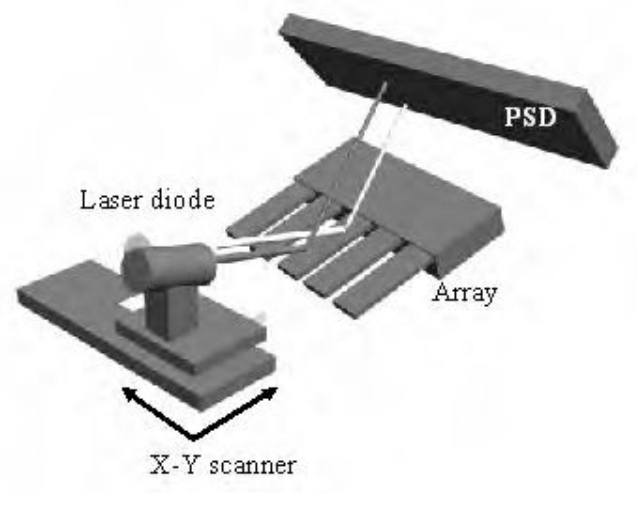
Figure 2 . Sketch of the profilometry system. The laser is mounted in a 2-D voice-coil actuator. The beam can scan the cantilever array in the X and Y directions. The beam reflected of the cantilever surface is collected in a position sensitive